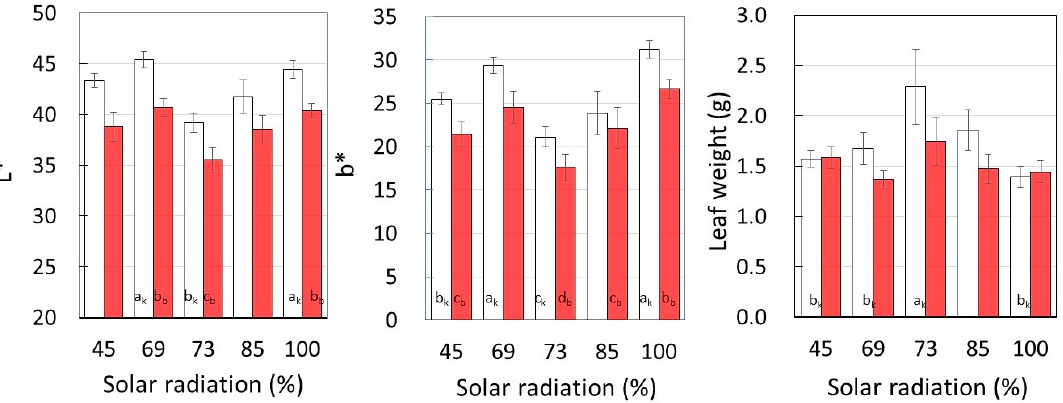
Figure 5. Leaf surface lightness (L*) and yellowness (b*) in each solar radiation, and individual leaf weight. □ ; Suikenkintoki , ■ ; Beniharuka . Data are the means and error bars represent standard error of the mean. Different letters indicate statistically significant differences between cultivation layers ( p < 0.05).